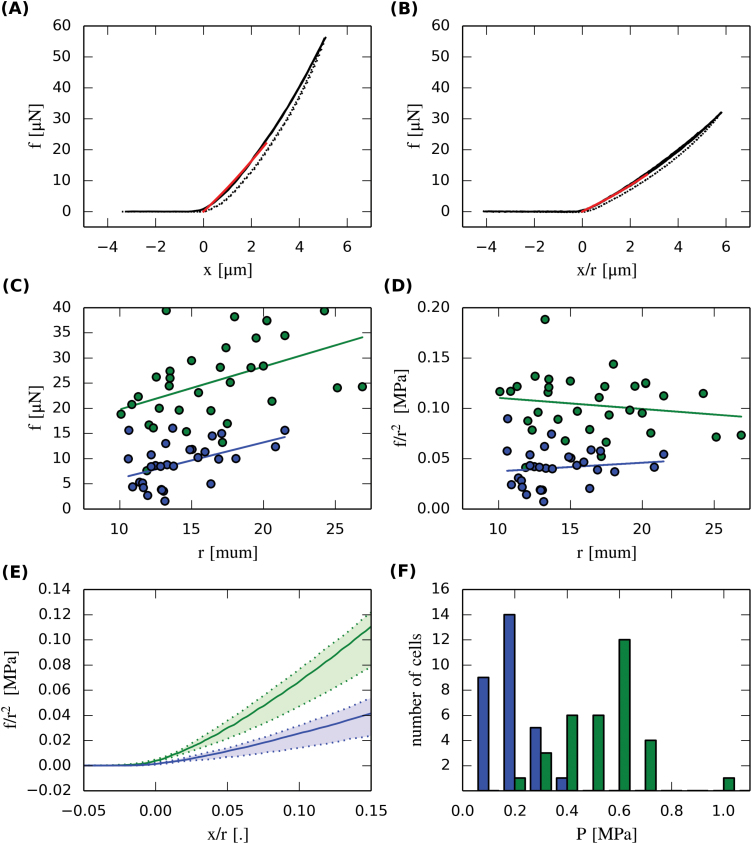
CFM measurements and pressure estimates. (A, B) CFM data for a BY-2 cell in water (A) and for another cell in 0.2M mannitol solution (B). Solid lines represent the movement into the sample and dashed lines denote the retraction phase. Red lines denote the model fit to the experimental data. (C) The force at x=2.3 μm was correlated with radius under both osmotic conditions [green=0M, blue=0.2M in (C)–(E)]. (D) This correlation disappeared when we rescaled force and indentation and reported values at x/r=0.15. (E) Summary of all CFM data. Solid lines denote the median of each group and the shaded area covers the 25–75% percentile. (F) Histogram of turgor pressure obtained by combining CFM, osmotic treatments, and inverse finite-element modelling.